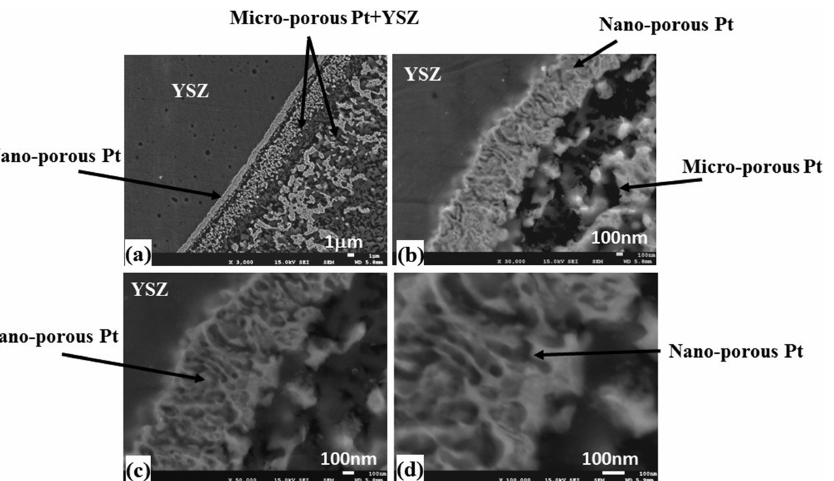
Figure 10: Interface between Pt cathode and YSZ after experiment (maximum potential: 4 V). (a) Microscopic image and (b), (c), and (d) are increasing